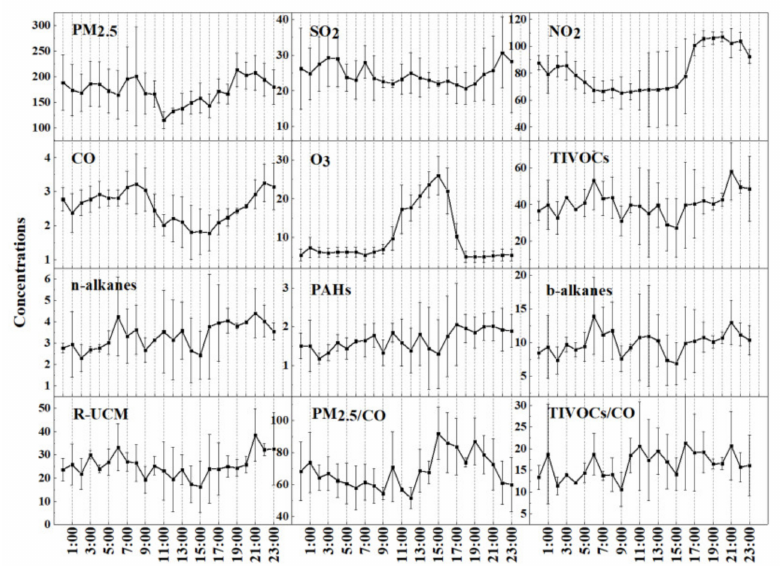
Figure 5. Diurnal variations of PM 2.5 , gaseous precursors, and IVOC components during the haze